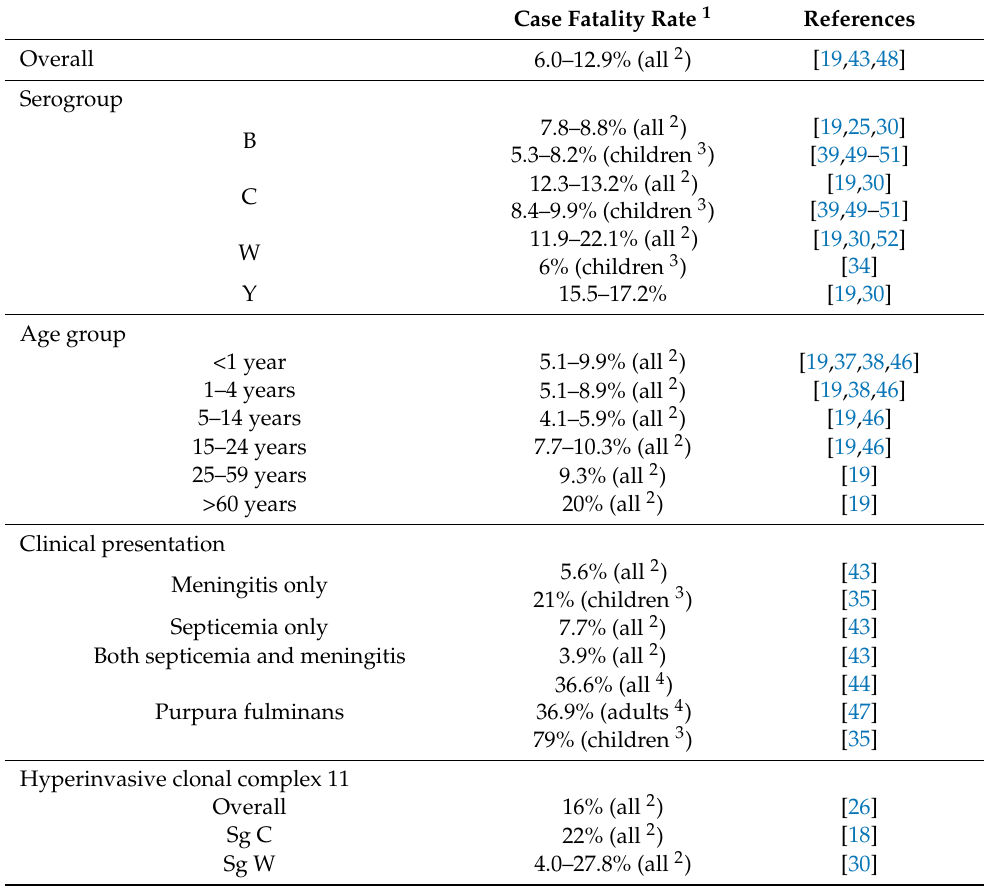
Table 2. Case fatality rate (%) by serogroup, age group, clinical presentation, and hyperinvasive clonal complex.